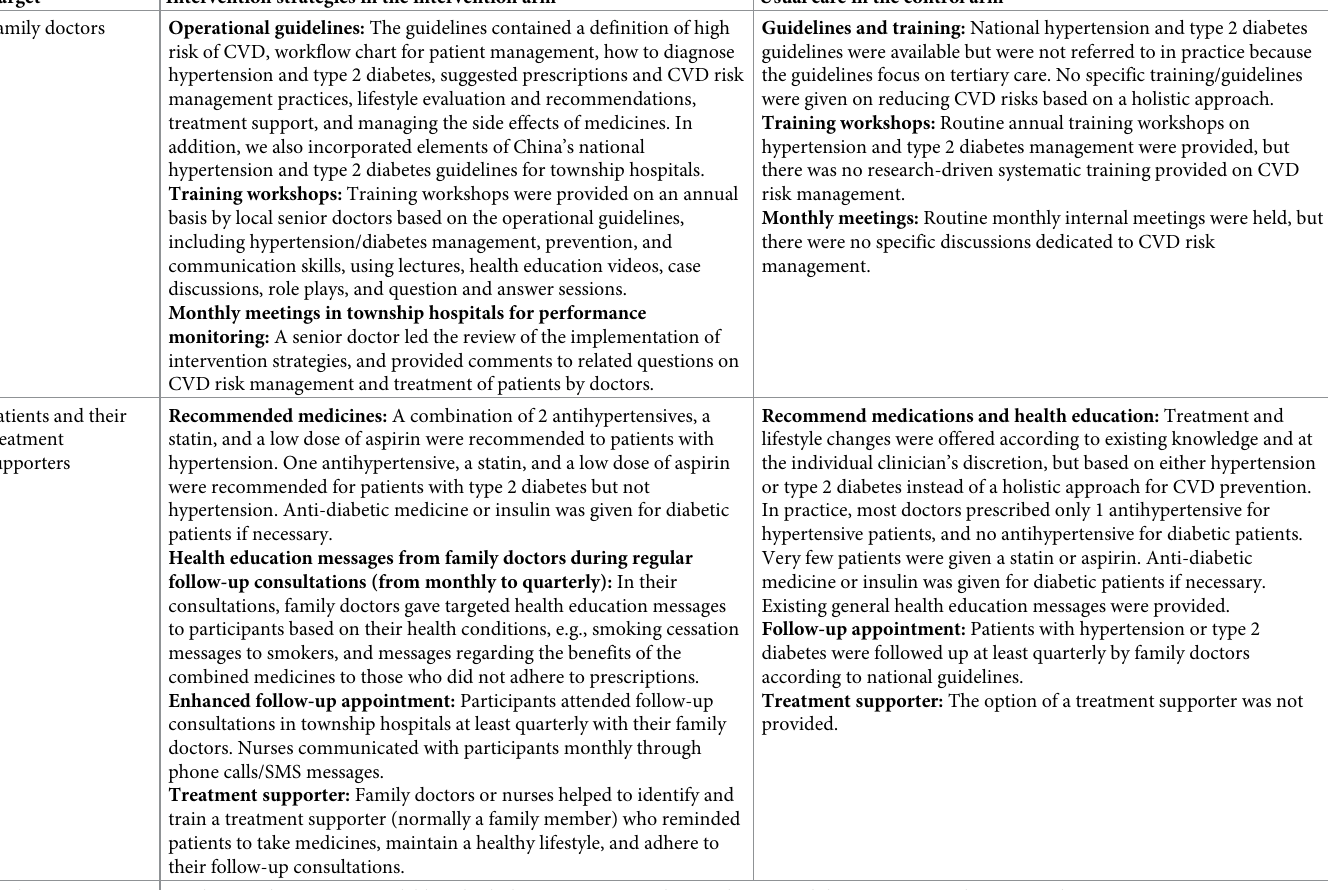
Table 1. Intervention strategies to reduce the risk of cardiovascular disease